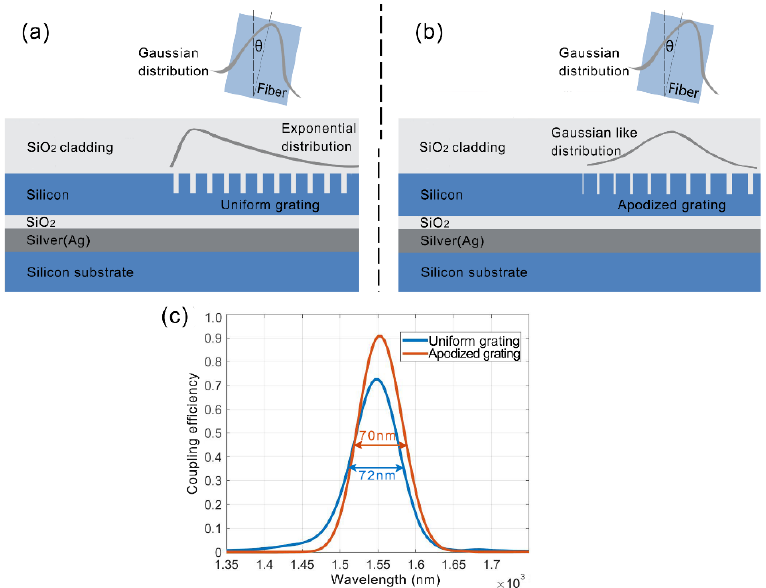
Figure 1. 2D schematics of the uniform ( a ) and apodized ( b ) grating couplers for the silicon HPWs with a bottom metal layer. ( c ) Simulated transmission spectra of them with optimal structures.